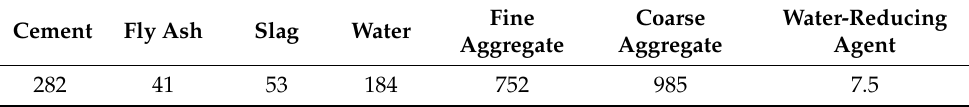
Table 3. Reinforcement parameters.